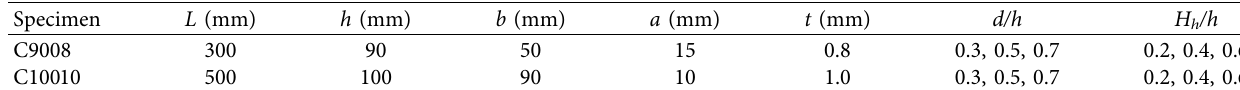
Table 1: Nominal dimensions of tested stud columns.